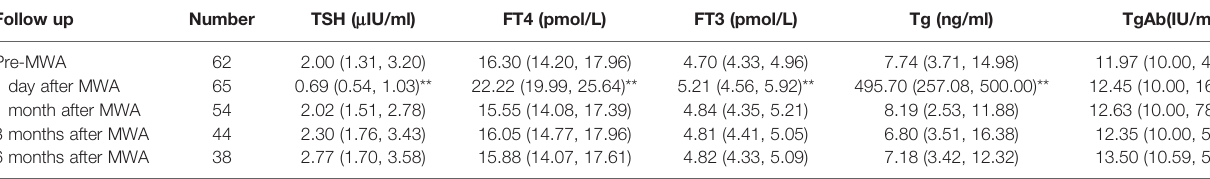
TABLE 3 | Changes in thyroid function after MWA. Follow up